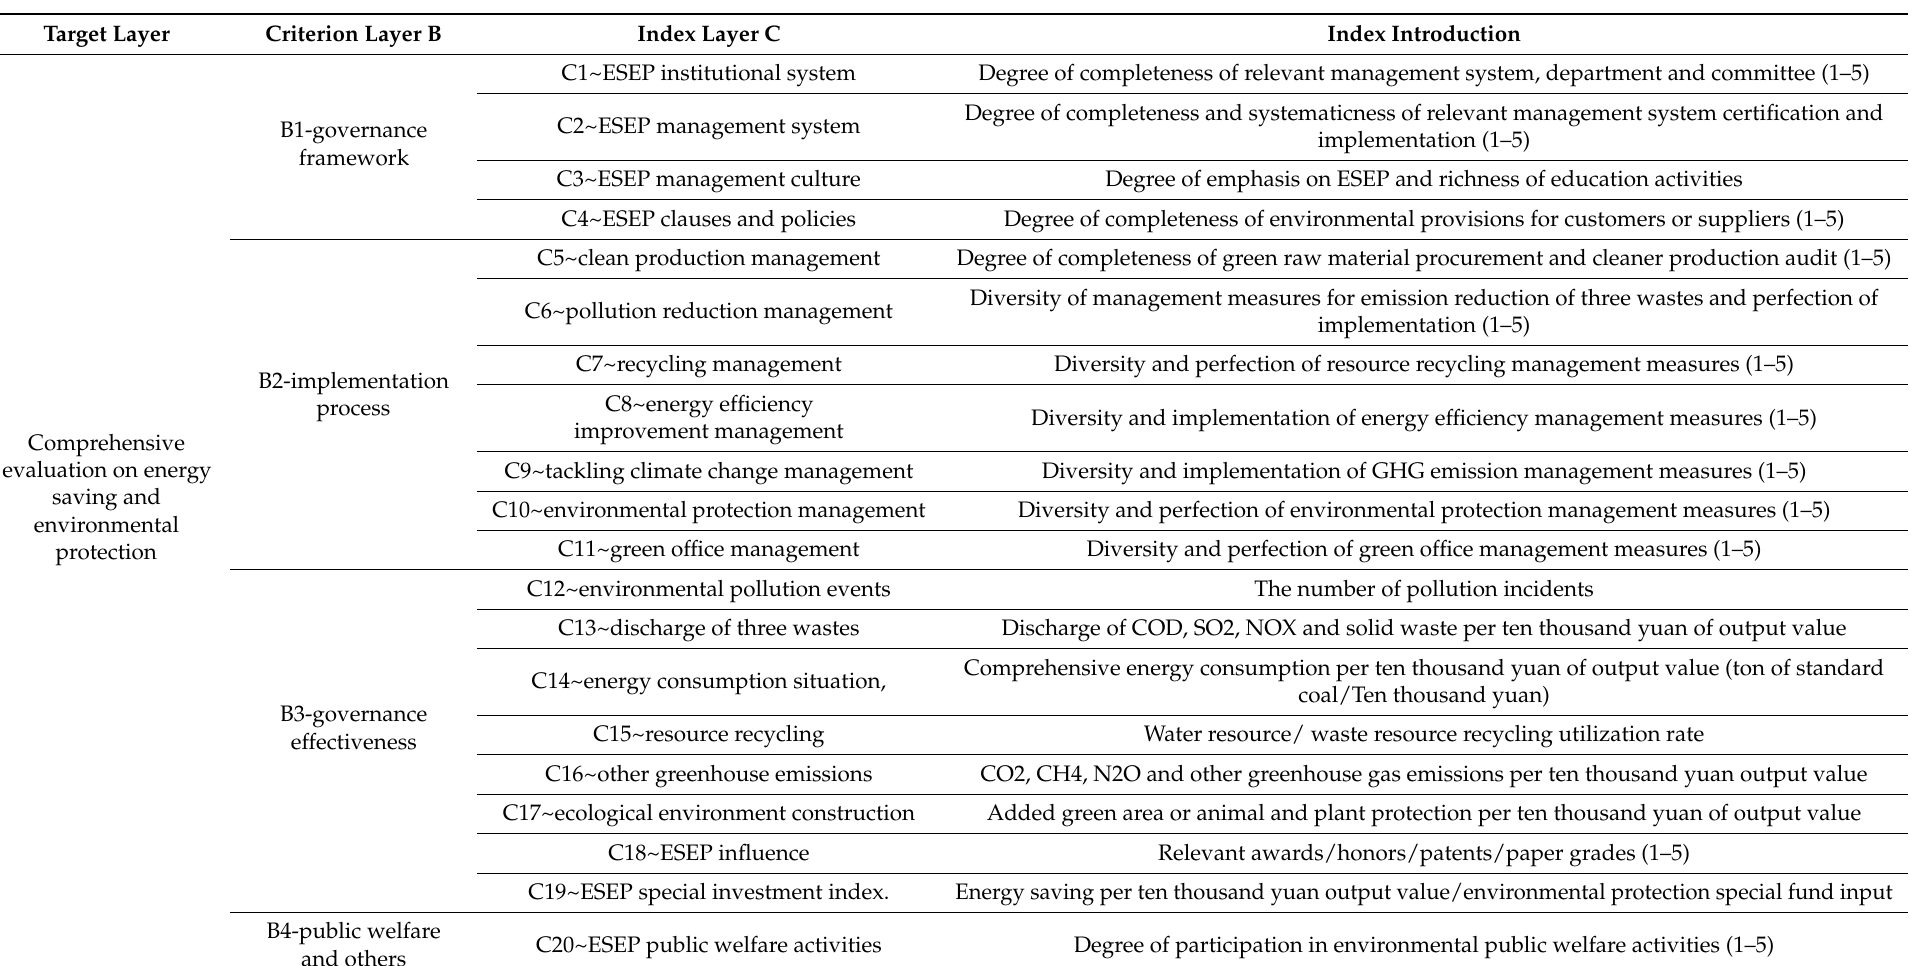
Table 1. Energy saving and environmental protection (ESEP) management evaluation index system of listed companies in the energy